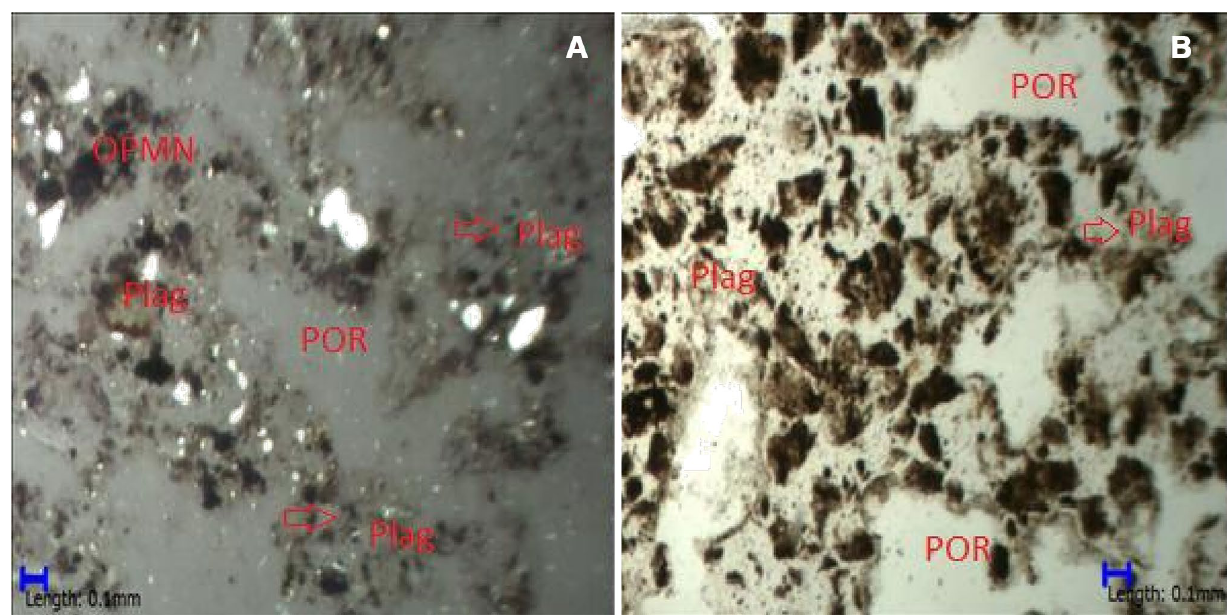
Fig. 11 a, b Showing Plagioclase Feldspar grain in Ajegunle A4 at depth 63–66 m under plane polarised light (PPL) and at Ajegunle A4 at depth 75–78 m under cross polarised light (nicol)